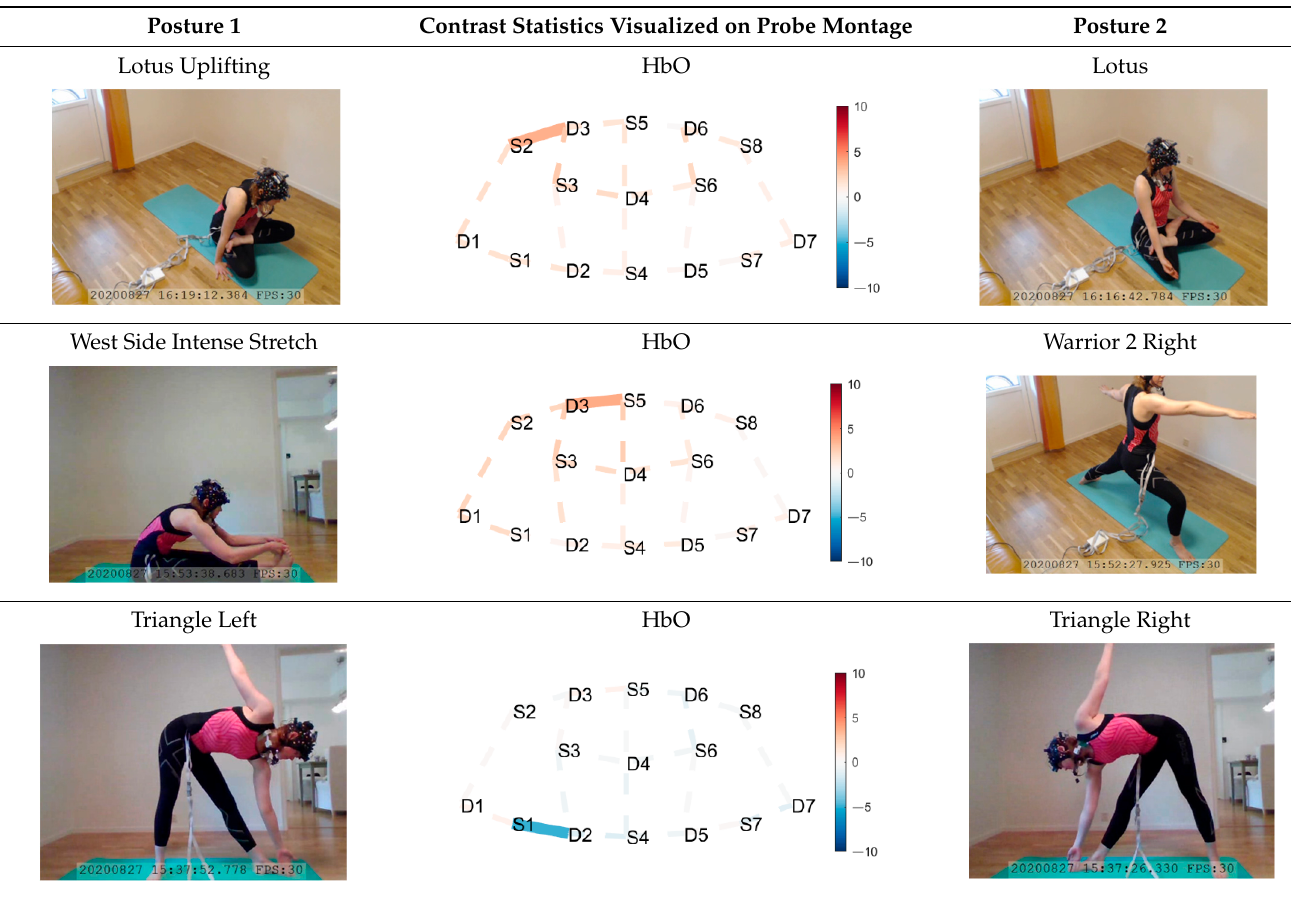
Table 3. Contrasts postures with little significant difference. Contrasts are shown as t -tests of Posture 1 minus Posture 2 1 . Posture 1 Contrast Statistics Visualized on Probe Montage Lotus Uplifting